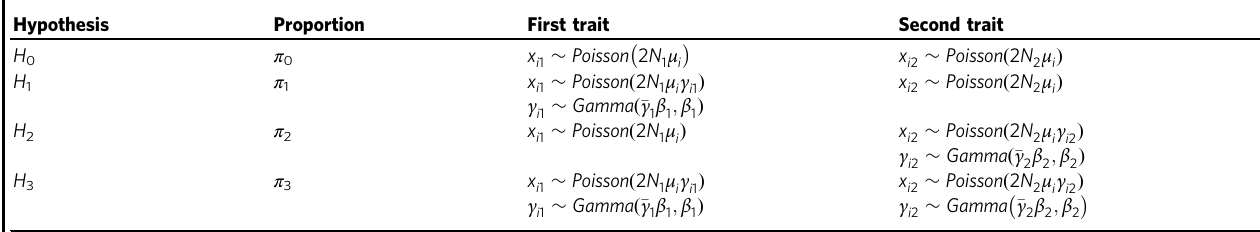
Table 1 Statistical models of mTADA. Hypothesis Proportion First trait